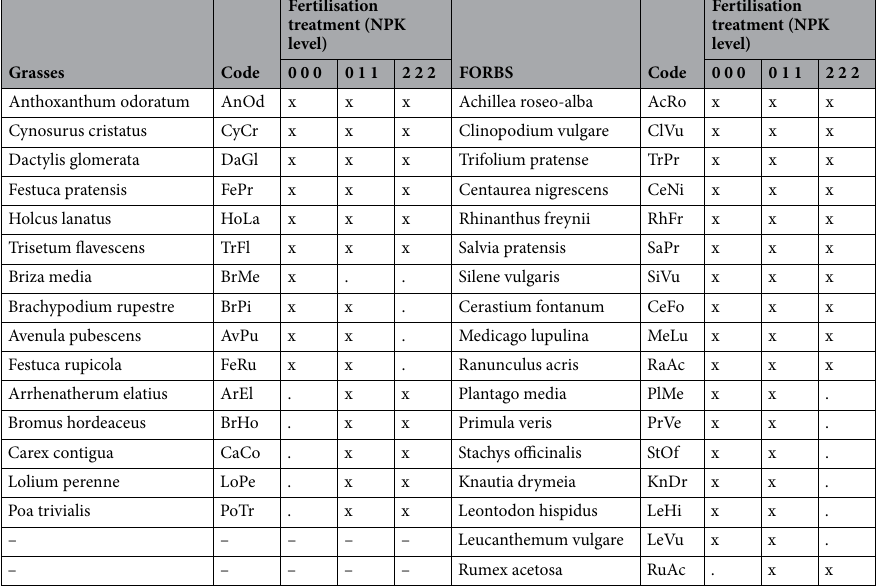
were placed on filter paper in petri-dishes and moved to a germinator for 4 weeks (8 h light/25 °C and 16 h dark- ness/15 °C) with weekly observation and extraction of germinated seeds. At the end of the germination test, seeds that had not germinated were checked for viability with the tetrazolium test. Total viability was calculated as the sum of germinability and viability of non-germinated seeds. All shoots collected on the sub-plots were counted and measured for the number of inflorescences and flowers. When inflorescences and flowers were too numerous to be counted rapidly (e.g., in all grasses), only the same length/diameter measured on the 15–30 shoot samples was recorded. A more detailed description of the laboratory analyses is available in Scotton 20 . Data analysis. The value of each reproductive trait was calculated for each year and growth period at the plot level for each species. The values of the traits describing the size of the reproductive system were obtained from the shoots collected on the sub-plots. However, for species with too many flowers per shoot, a relation was calculated between the flowers per shoot and the length/diameter of the inflorescences measured on the 15–30 shoot samples. This relationship was then used to calculate the flower number for each shoot. The number of ovules per flower, the portion of ovules transformed to seed (ovule site utilisation, i.e. the filled seed/ovule ratio), the 1000-seed weight, germinability, and viability were calculated from the results of lab analyses of the 15–30 shoot samples. Because all the species collected were not always present in the six study years, only the thirty-two species (fifteen grasses and seventeen forbs: Table 1) found in at least three of the study years were considered in this paper to obtain enough reliable results. For all grasses, data were available only for the first growth period. For four forbs (see Annex 3) data were available for the first and second growth periods: in these cases, the average values of the two periods were used in the analyses. The statistical analyses were performed at the levels of individual species and the two grassland functional groups (grasses and forbs). Nine main reproductive traits describing the whole process of gamic reproduction were considered: number of simple inflorescences per shoot, flowers per simple inflorescence, ovules per flower, ovules and viable seeds per shoot, OSU (ovule site utilization), percent viability, germinability, and seed weight. Percent dormancy (the difference between percent viability and germinability) and the shoot density recorded in the subplots were also considered in some analyses. Only sixteen species were present in all of the fertilisation treatments, presenting a challenge in the tests that included all of the species together because a balanced among-treatments comparison was only possible by discarding the data from species not present in all of the treatments. To overcome this issue, we assumed that due to symbiotic N-fixation, the high presence of legumes in the 011 treatment (fertilization with P and K) was equivalent to a yearly N fertilisation of about 3.5 kg/ha per percent point of legume abundance in the species composition 21,22 . Therefore, treatment 011 (30% more legume abundance than in treatment 222: Annex 1) was regarded as an intermediate N addition of 105 kg per ha per year (from 3.5 kg N × 30% legume abundance). The values of the reproductive traits were then calculated for two fertilisation levels, low (LowFert) and high (High- Fert). For species present in 000 and 011, LowFert was 000 and HighFert was 011. For species present in 011 and 222, LowFert was 011 and HighFert was 222. For species present in three fertilisation treatments, LowFert